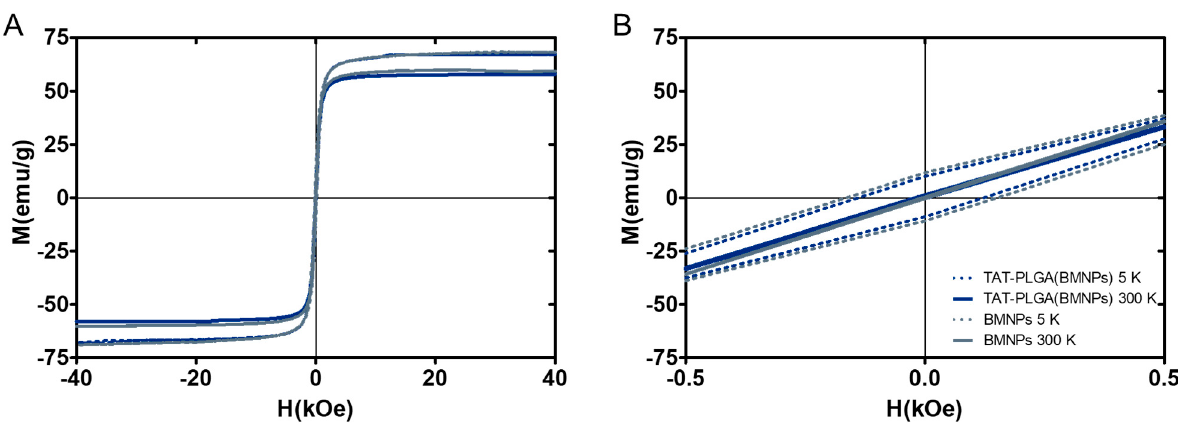
Figure 1. Hysteresis cycles of TAT-PLGA(BMNPs) and BMNPs. ( A ) Magnetization cycles of TAT-PLGA(BMNPs) and bare BMNPs at 5 and 300 K, showing the ferromagnetic and the superparamagnetic behavior. ( B ) Magnifications of the low-field region.